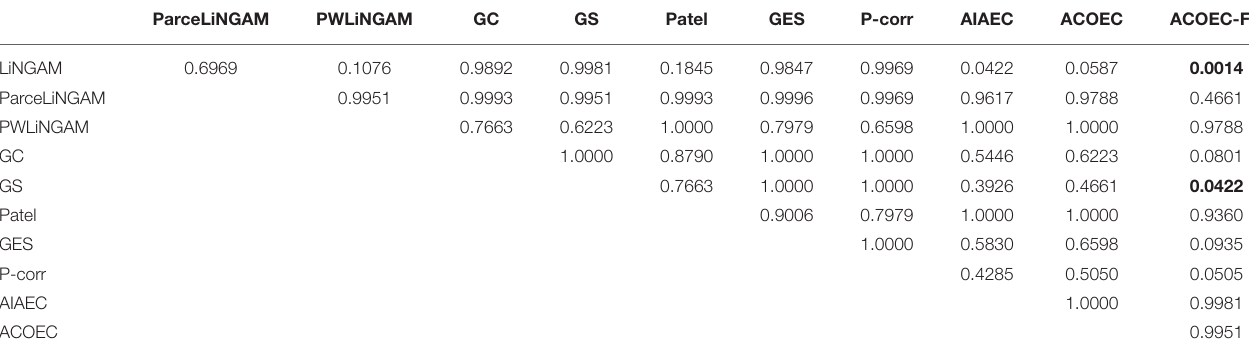
TABLE 7 | The post-hoc test results of p -values on F1